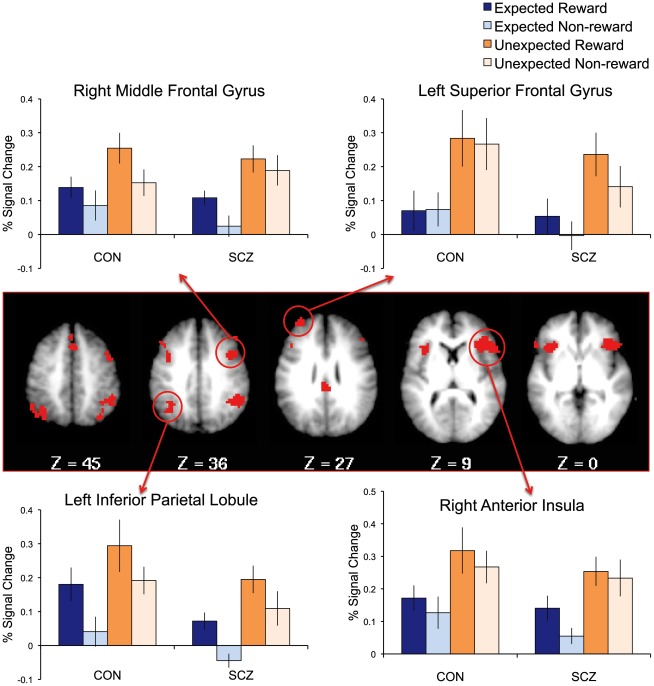
Regions demonstrating a Cue X Receipt interaction.All regions showed greater activity for unexpected than for expected outcomes. Both ROI results (threshold of p<.01 and 19 voxels within ROI mask) and whole-brain results (threshold of p<.003 and 13 voxels) are displayed. Graphs represent mean activation magnitudes across voxels within example regions among individuals with schizophrenia (SCZ) and controls (CON). Error bars represent standard error.